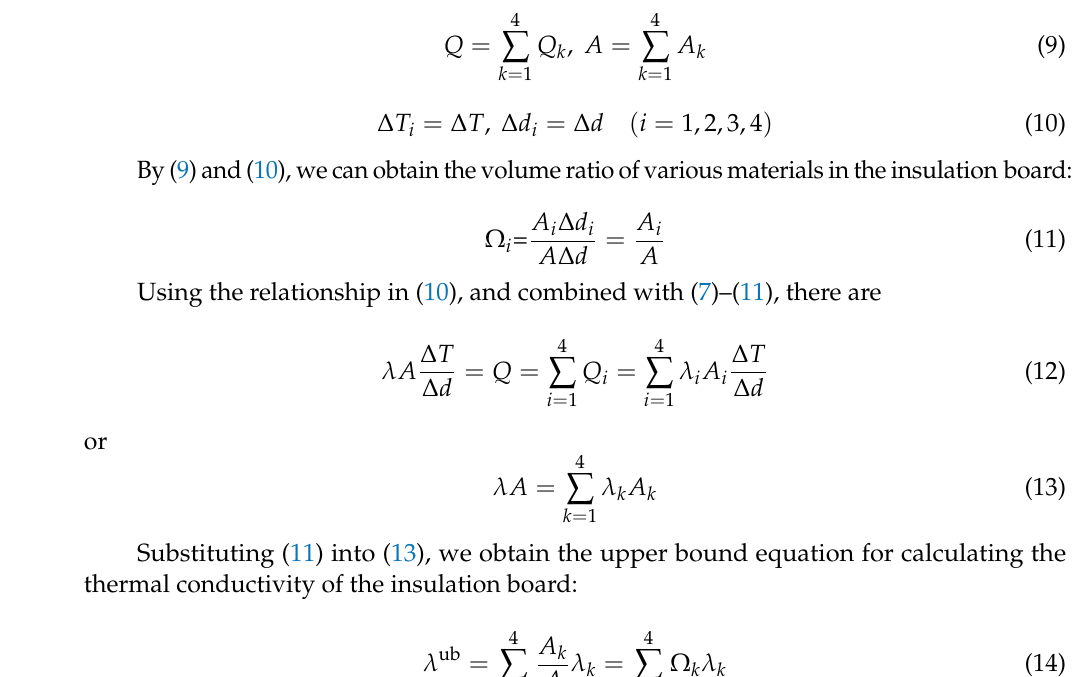
Figure 5. Theoretical model of equivalent thermal conductivity of the GCIB: ( a ) the parallel model; ( b ) the series